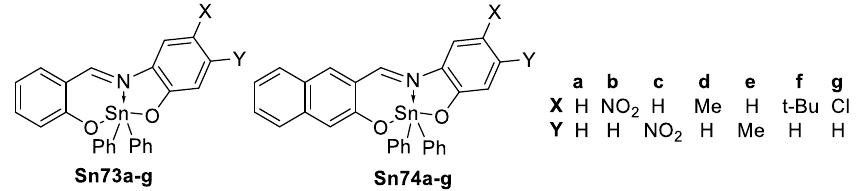
Figure 54. Diphenyl tin complexes reported by Peon et al. (Adapted with permission from [109]. Zugazagoitia, J.S.; Maya, M.; Dami á n-Zea, C.; Navarro, P.; Beltr á n, H. I.; Peon, J. Excited-State Dynamics and Two-Photon Absorption Cross Sections of Fluorescent Diphenyl-Tin IV Derivatives with Schiff Bases: A Comparative Study of the Effect of Chelation from the Ultrafast to the Steady-State Time Scale. Copyright 2010 American Chemical